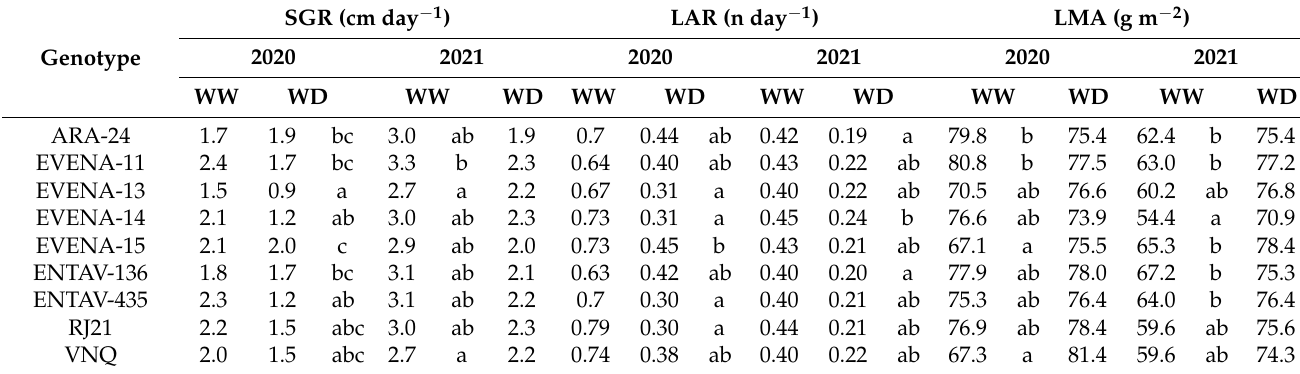
Table 3. Shoot growth rate (SGR), leaf area appearance rate (LAR) and leaf mass area (LMA) for each of the 9 “Grenache” genotypes under well-watered (WW) and water deficit (WD) conditions during